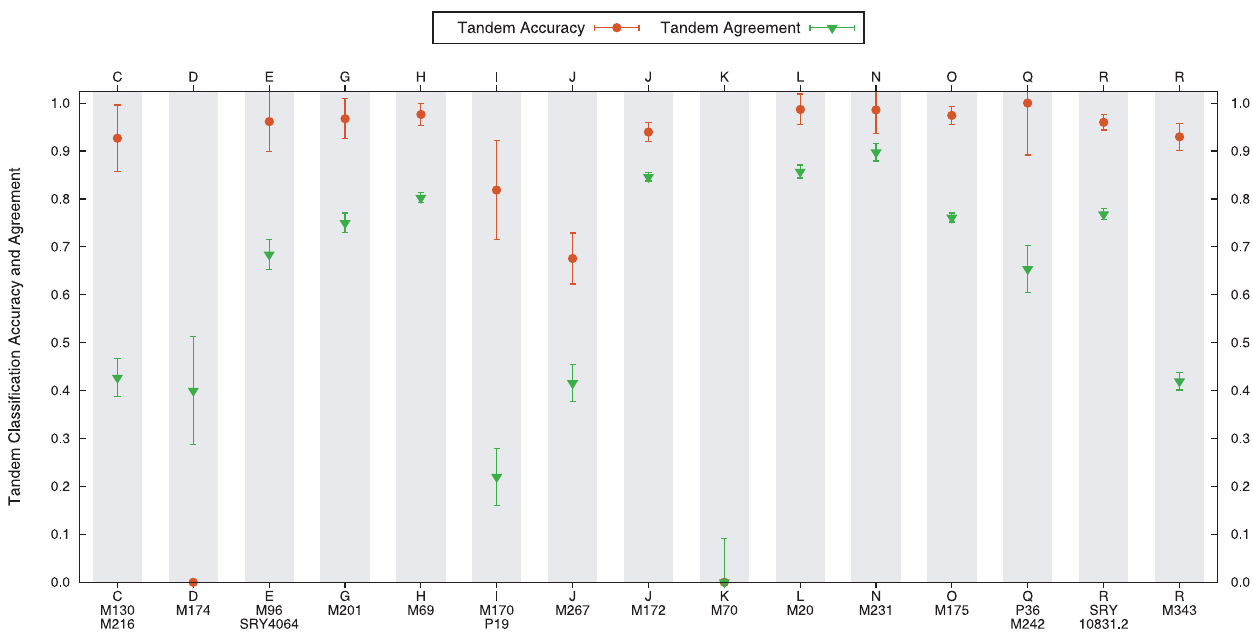
Figure 6. Average accuracy and agreement of the tandem approach for cross-validation on the 9-locus public STR data.